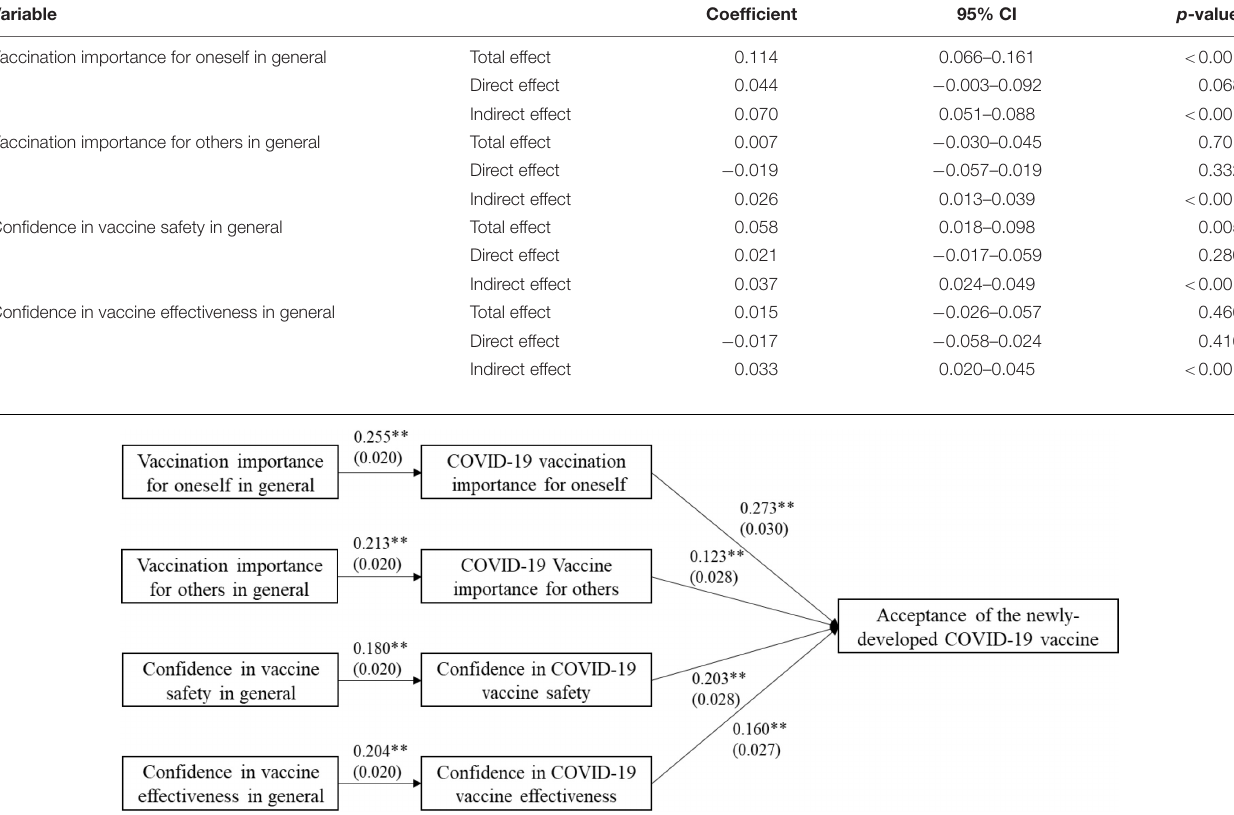
TABLE 4 | Effect of general vaccination perceptions on acceptance (attitude) of the COVID-19 vaccine by path analysis.